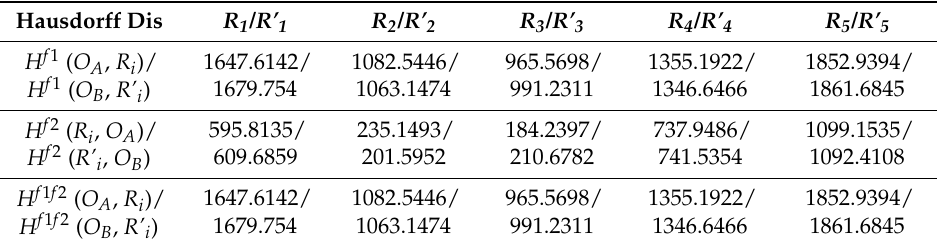
Table 4. Hausdorff distance calculation results for Scenes A and B .